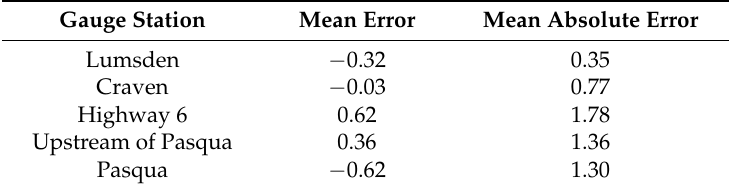
Table 1. Model bias and prediction error.